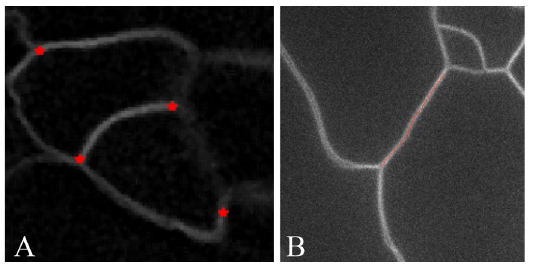
Figure 8. ( A ) Extracted junctions of three cell walls, ( B ) Extracted anticlinal wall segment.